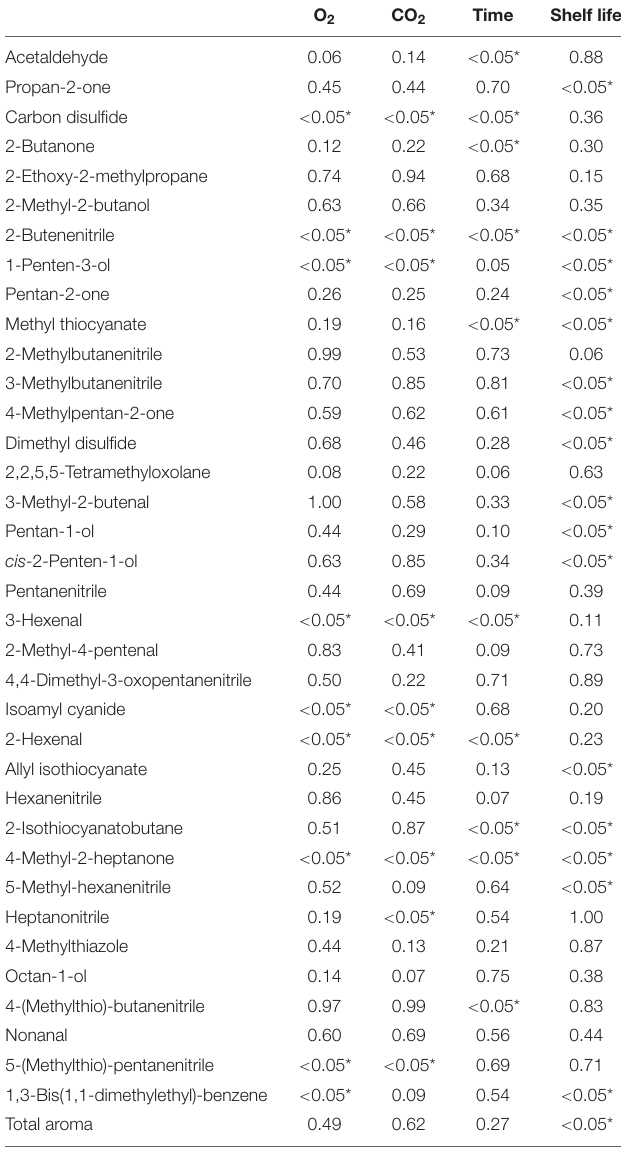
TABLE 4 | List of aroma compounds found in the headspace surrounding the cabbages in storage (SPME GC-MS). O 2 CO 2 Time Shelf